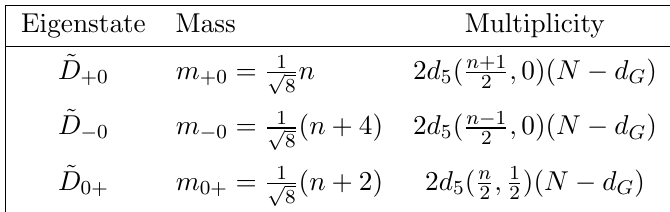
Table 6 . Mass eigenvalues of the fermions in the o(cid:11)-diagonal block. The de(cid:12)nition of d G can be found in